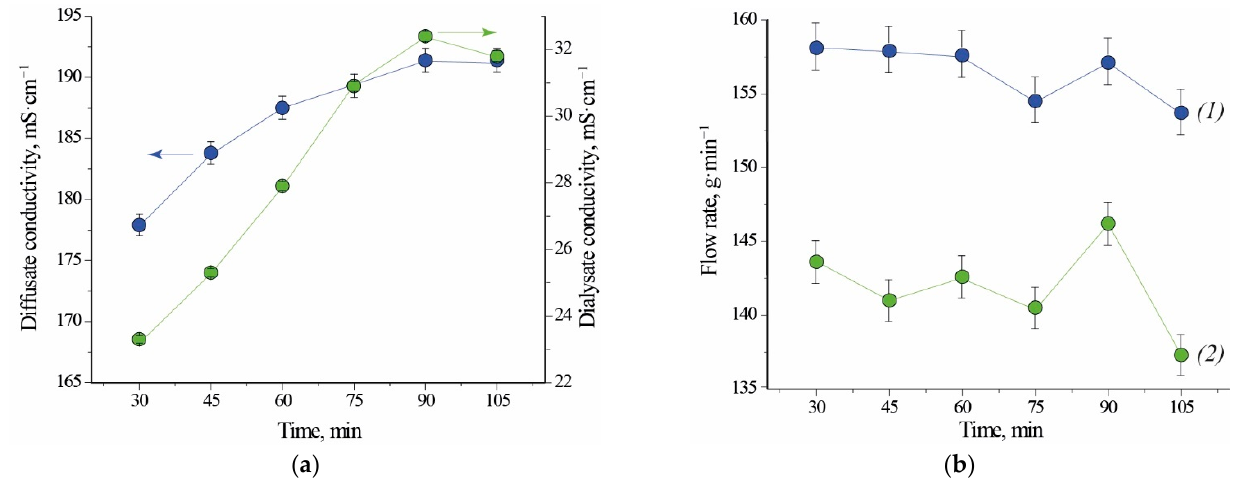
Figure 1. Conductivity ( a ) and flow rate ( b ) as a function of time for Test 1.1. (1) diffusate; (2) dialysate. Initial fill: water. Note that the lines connecting experimental points are not true trendlines.